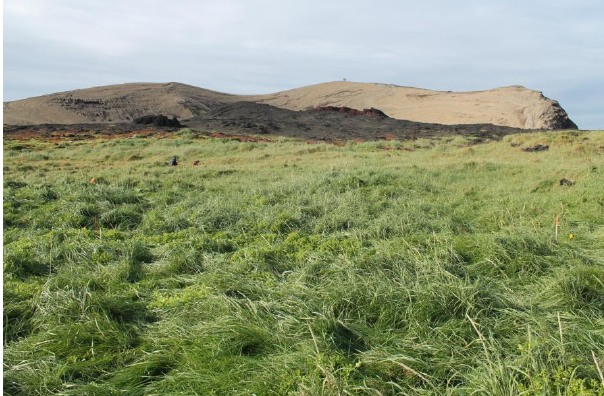
Figure 9. Poa pratensis/Leymus arenarius grassland in centre of gull colony (plot 1) on Surtsey in 2013. Upper-crater areas and palagonite ridges remain barren. Photo: BM.